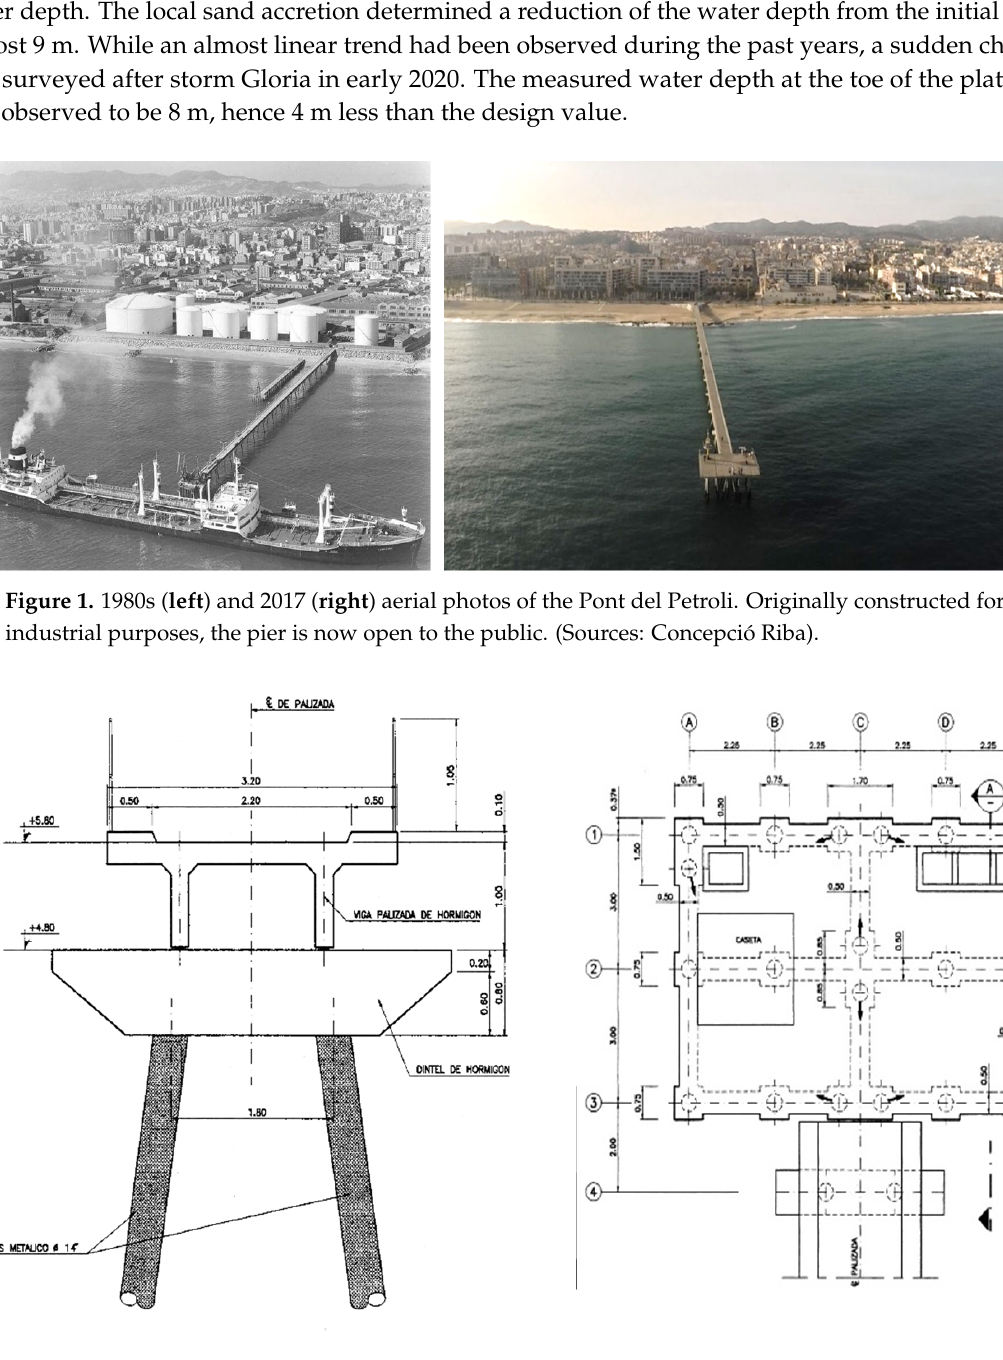
Figure 2. Geometrical details and top view of the platform, beam and pile cap forming the Pont del Petroli pier. The sketches are extracted from the first design report and provided by the